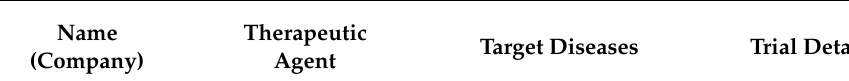
Table 2. MicroRNAs in clinical